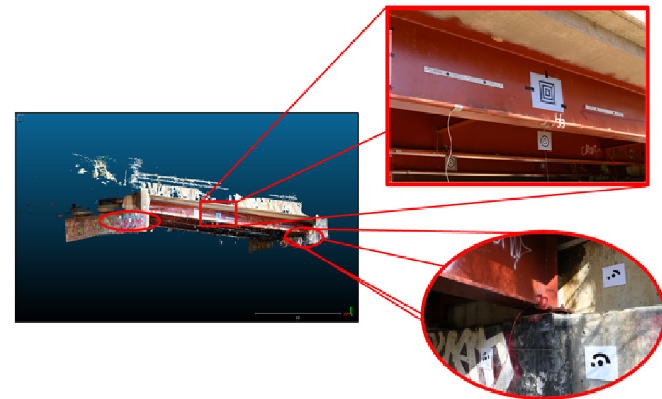
Figure 9. Placement of fiducial